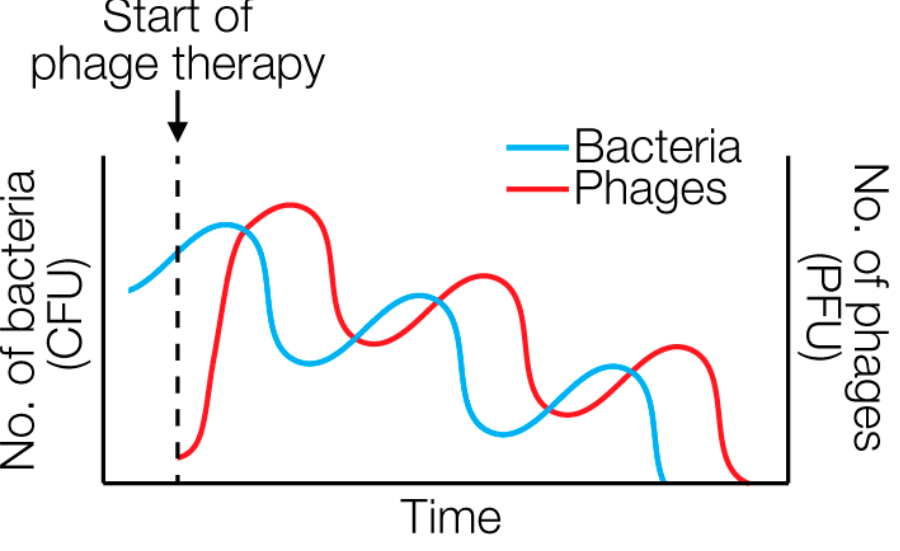
Figure 3. Population dynamics of bacteria and phages during phage therapy. The figure does not show actual data but represents typical growth curves observed experimentally. Phages are self-dosing (i.e., amplifying in the presence of the host bacterium) and self-limiting (i.e., cleared once the host bacterium is eliminated). PFU, plaque-forming units; CFU, colony-forming units.